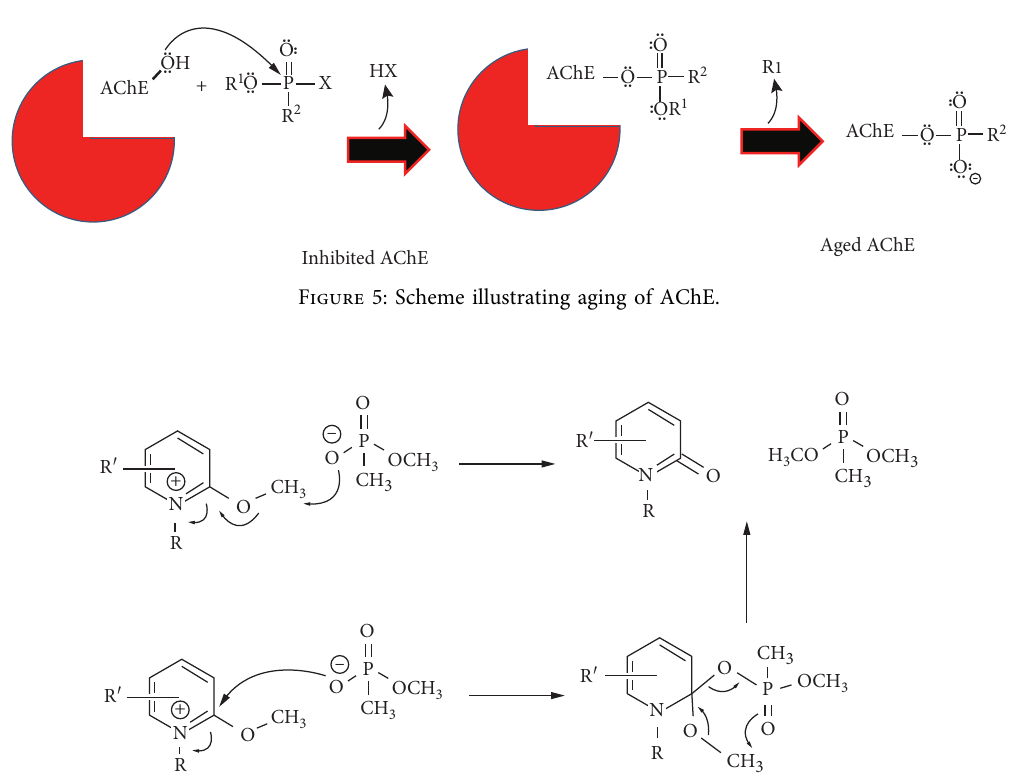
Figure 6: The alkylation of aged AChE with methoxypyridiniums. Two possible mechanisms of methyl transfer from methoxypyridiniums to phosphonates were proposed in [51]. Pictures were adapted from [50].